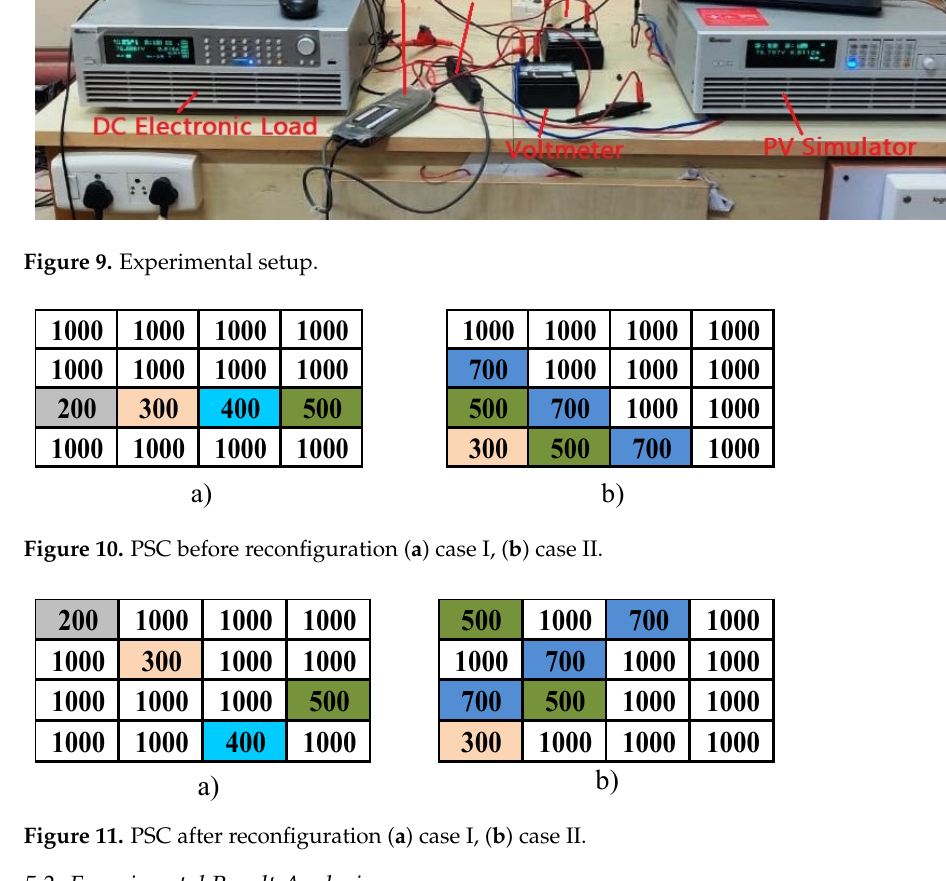
Figure 9. Experimental setup.